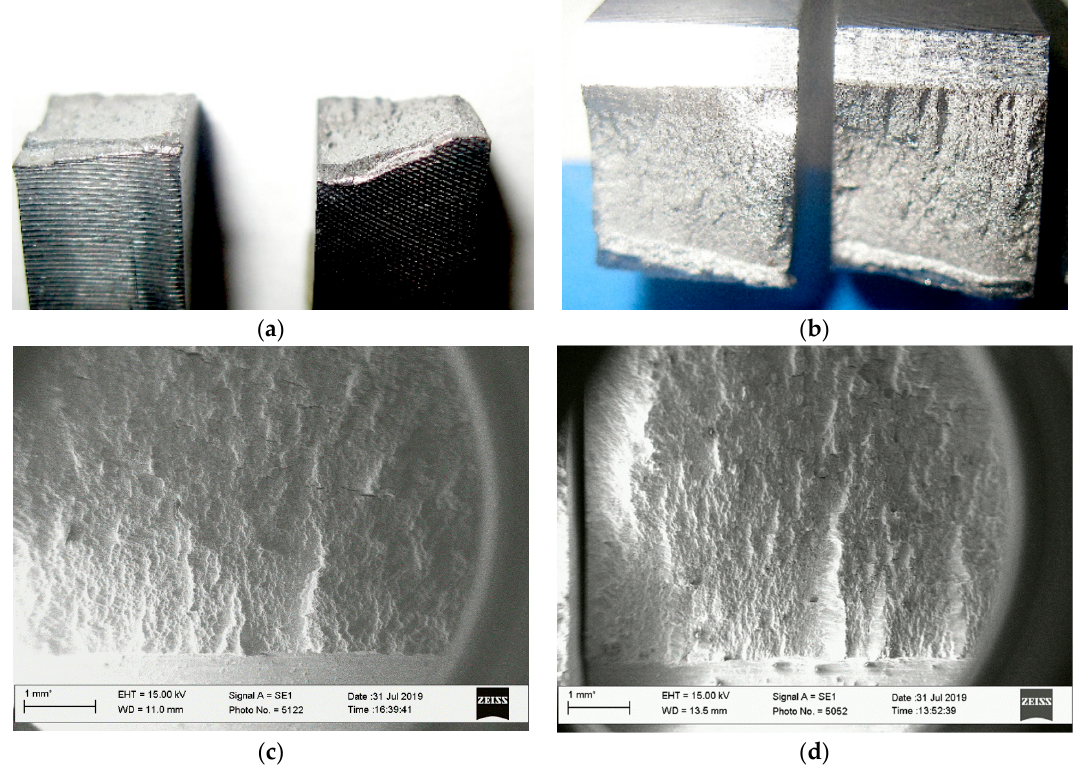
Figure 13. Profiles of the fracture surfaces of mode I-III test specimens: ( a ) Overview; ( b ), ( c ), ( d ) fracture features on the macro-level of the specimens.